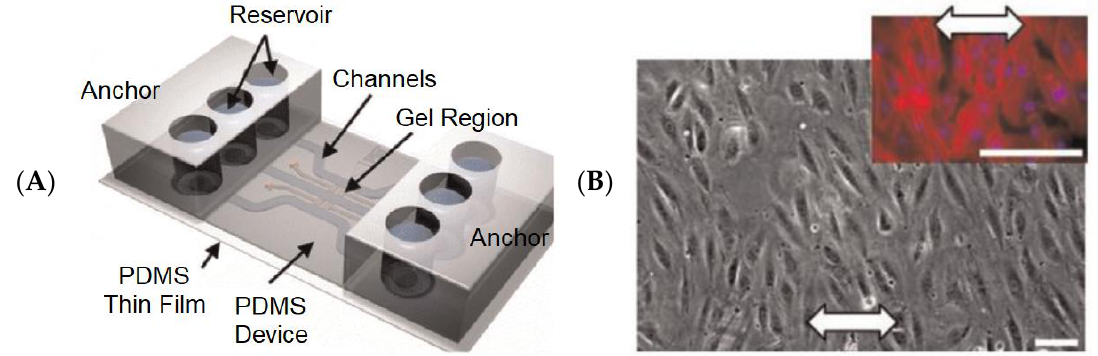
Figure 9. The heart-on-a-chip platform for culturing hMVECs [90]. ( A ) Schematic of the heart-on-a- chip. ( B ) Perpendicular alignment of hMVECs cultured in this heart-on-a-chip (10%, 1-Hz strain). Reproduced with permission from Elsevier Copyright (2023).